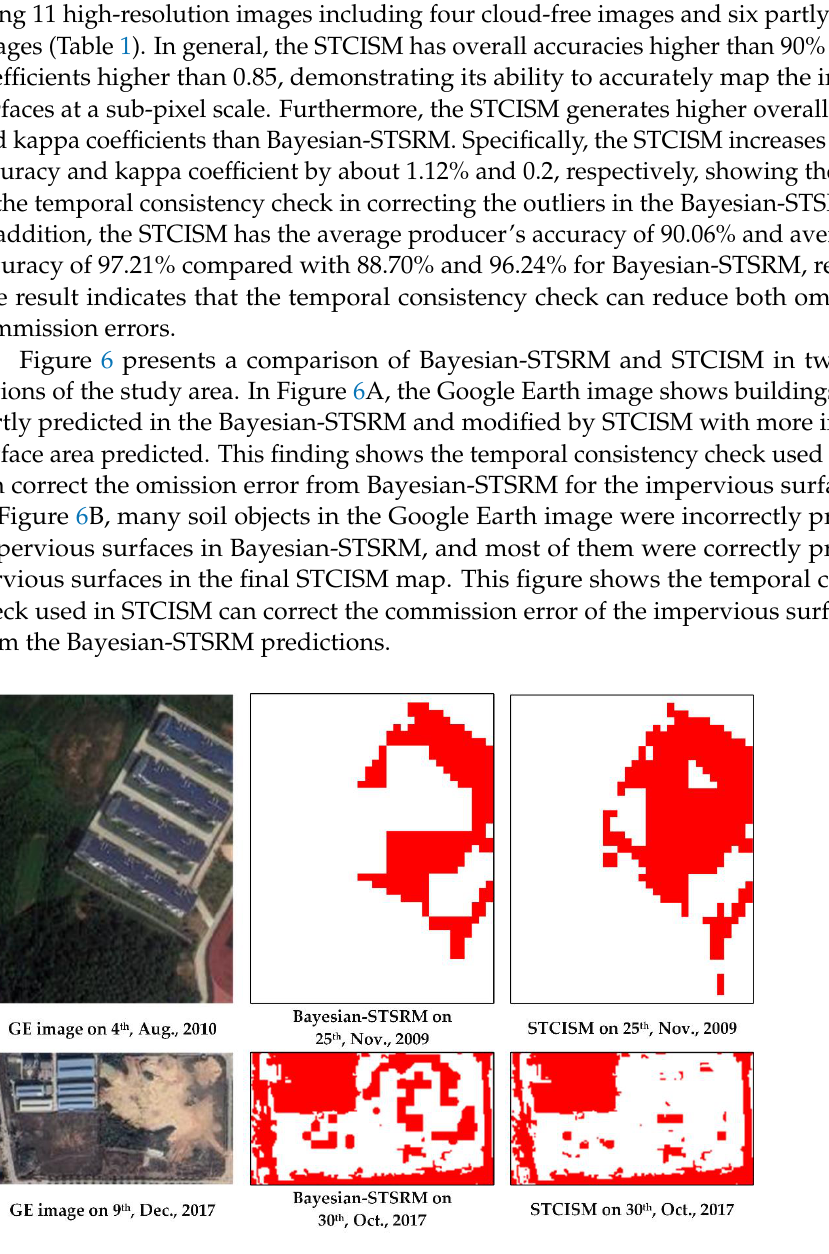
Figure 6. Visual comparison of the Bayesian-STSRM and STCISM predictions. Red and white represent impervious and pervious surfaces, respectively. GE: Google Earth. ( A ) buildings, ( B ) soil objects.